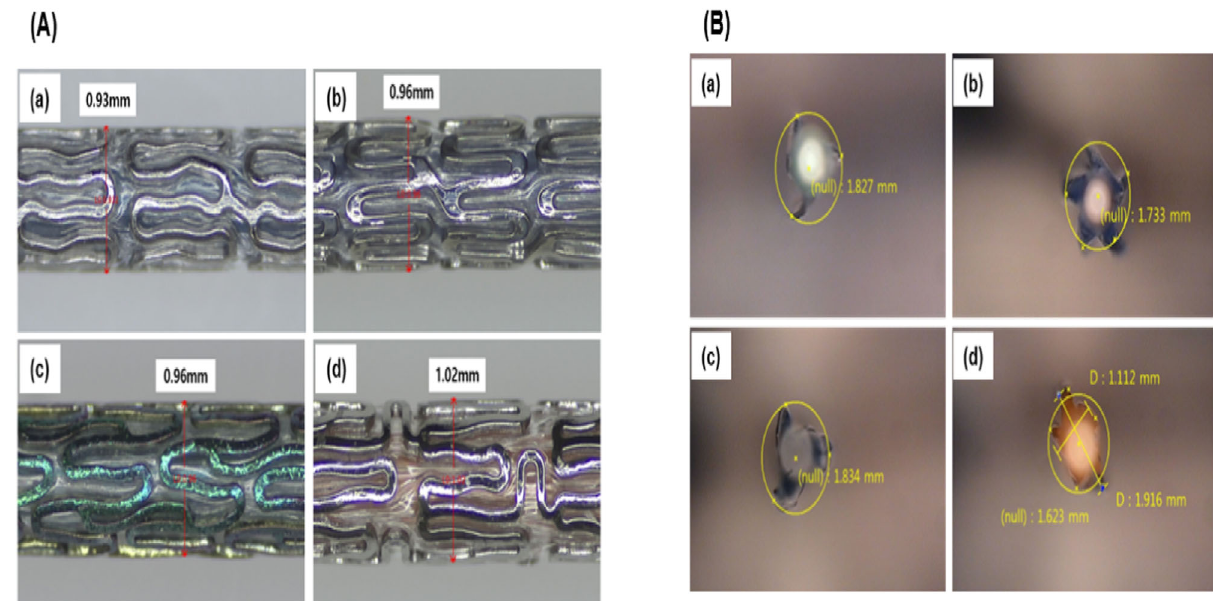
Fig. 2 Crossing pro fi le analysis result ( A ) and folding shape ( B ) of D + Storm ® DES (Drug eluting stent) (a), Synergy ™ (b), Orsiro ® (c), and Xience sierra ™